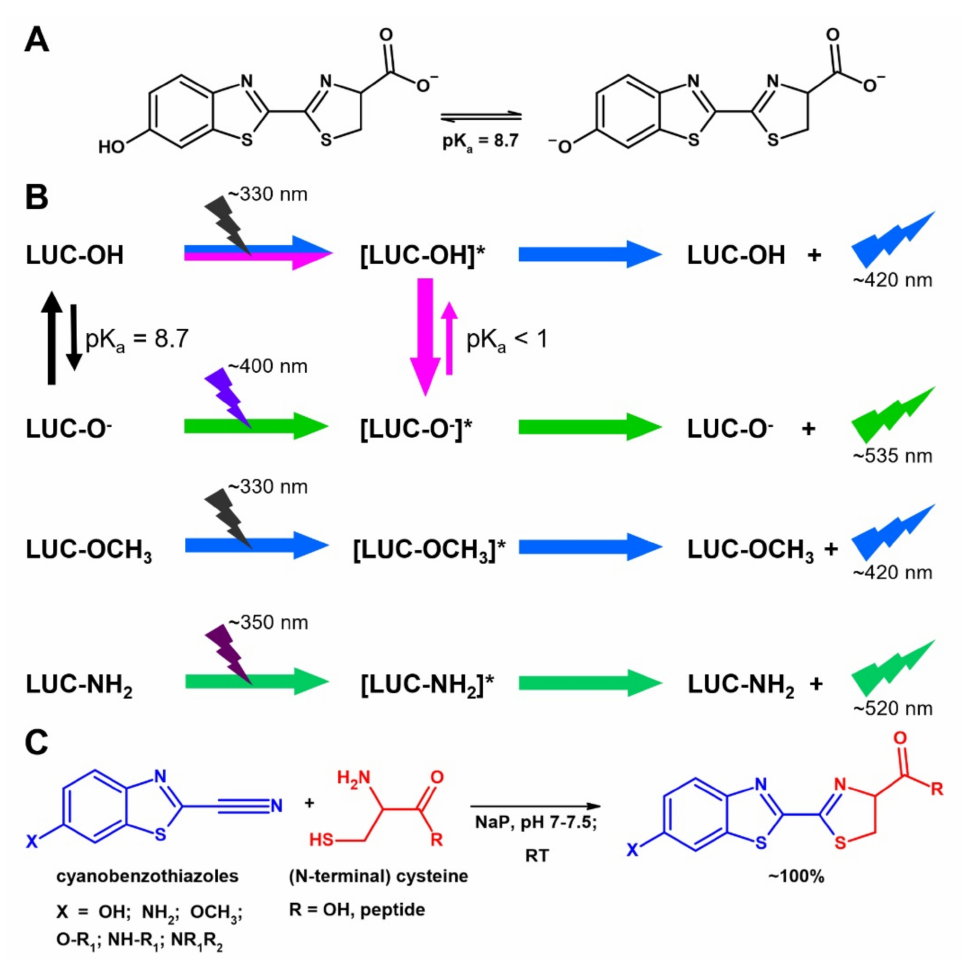
Figure 1. Structure, fluorescence and synthesis of luciferin and its analogues. ( A ) Structure of luciferin in phenol and phenolate forms. ( B ) Fluorescence of luciferin (Luc-OH), luciferin phenolate (Luc-O − ), methoxyluciferin (Luc-OCH3) and aminoluciferin (Luc-NH2). Excited states are indicated by an asterisk. ( C ) Condensation reaction between 6-substituted 2-cyanobenzothiazoles and cysteine (free or as N-terminal residue of a peptide). R 1 and R 2 can be a wide variety of alkyl and acyl groups. The nature of R 1 and R 2 has little or no impact on the reaction but can strongly influence